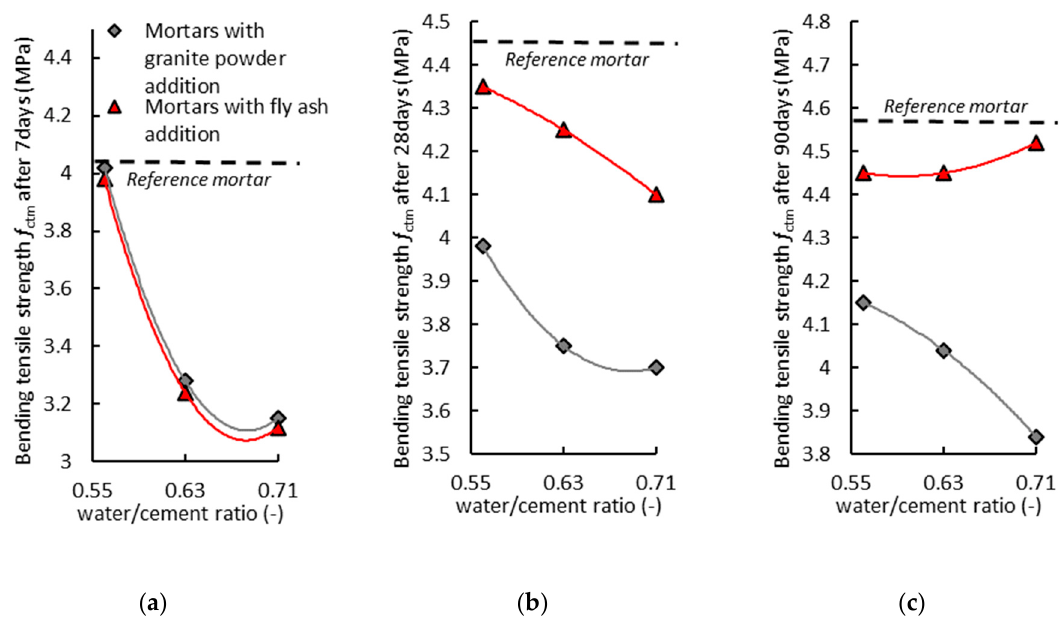
Figure 14. The effect of the water/cement ratio (w/c) value on the bending tensile strength ( f ctm ) of the air-cured hardened cementitious mortars: ( a ) after 7 days, ( b ) after 28 days, and ( c ) after 90 days.